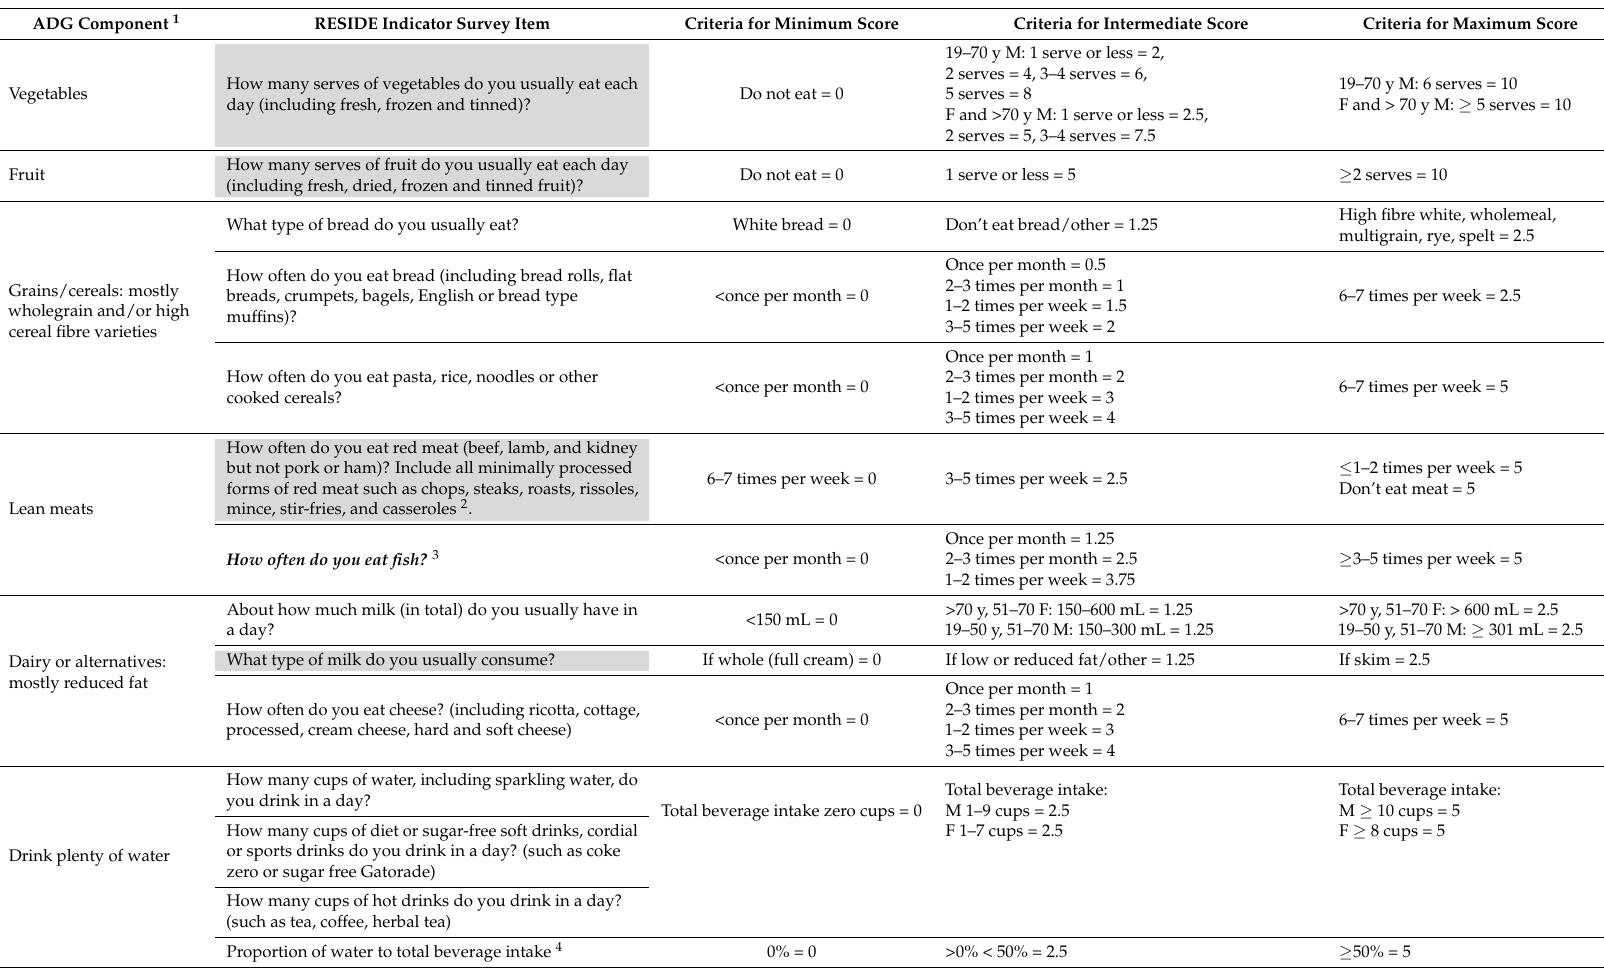
Table 1. Index components and scoring criteria for the RESIDential Environments dietary guideline index (RDGI). The six survey items available at T1, T2, T3, and T4 are highlighted and the additional three items available at T2, T3, and T4 are in bold italic . ADG Component 1 RESIDE Indicator Survey Item Criteria for Minimum Score Criteria for Intermediate Score Criteria for Maximum